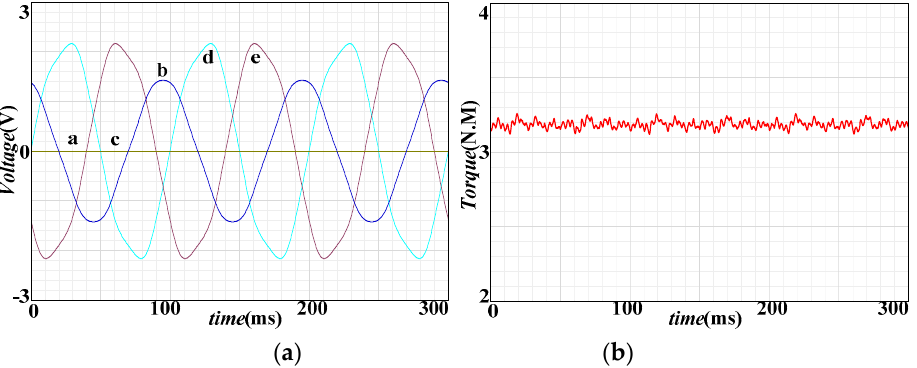
Figure 11. Fault-tolerant current and torque waveforms with compensation under AC open-phase condition: ( a ) current of TC; ( b ) torque of TC.